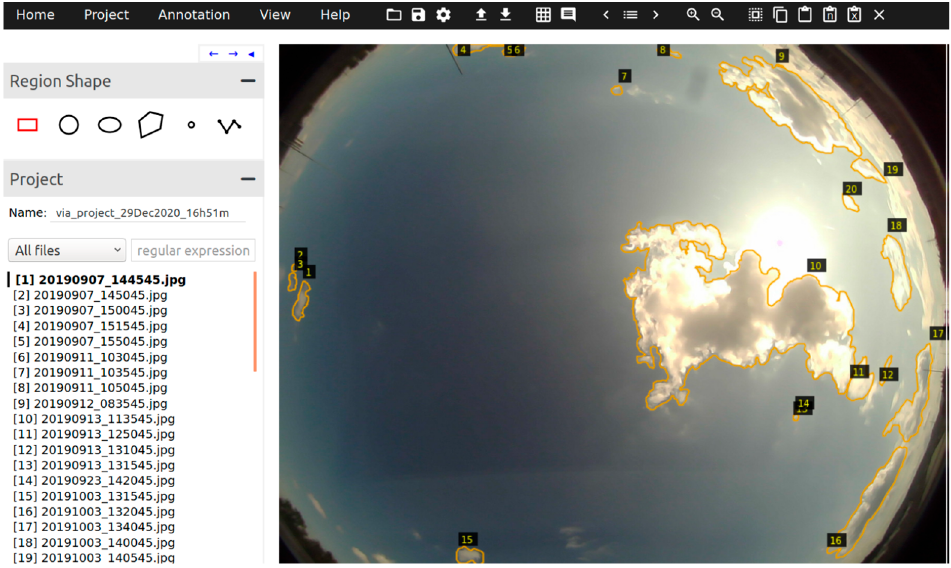
Figure 8. Screenshot of an annotated training data image with clouds in the peripheral area.